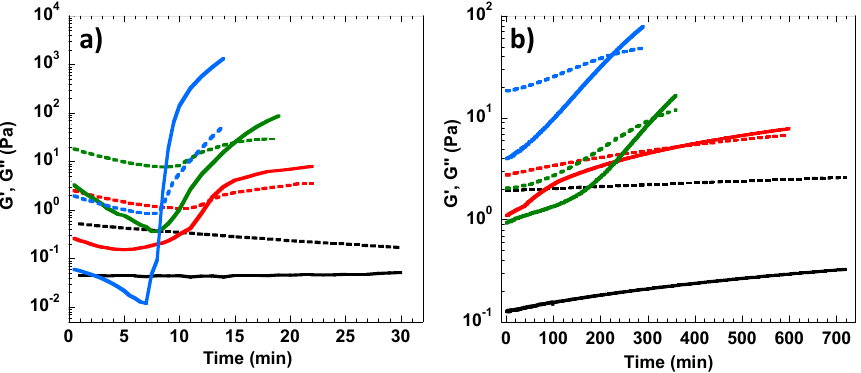
Figure 2. Storage modulus G’ (solid lines) and loss modulus G’’ (dashed lines) of 2 wt.% cellulose solutions with different MBA/glucose molar ratios: 0 (black), 0.26 (red), 0.53 (green) and 1.05 (blue) cured in different conditions: ( a ) temperature ramping from 23 °C to 60 °C during the first 10 min followed by 20 min at 60 °C, ( b ) cured at 23 °C for 720 min.